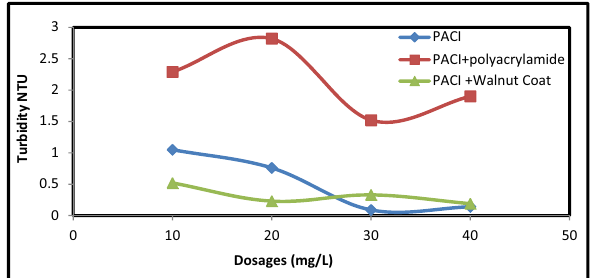
Figure 21: The relation between coagulant aids and fi nal turbidity for water samples at a height of 240